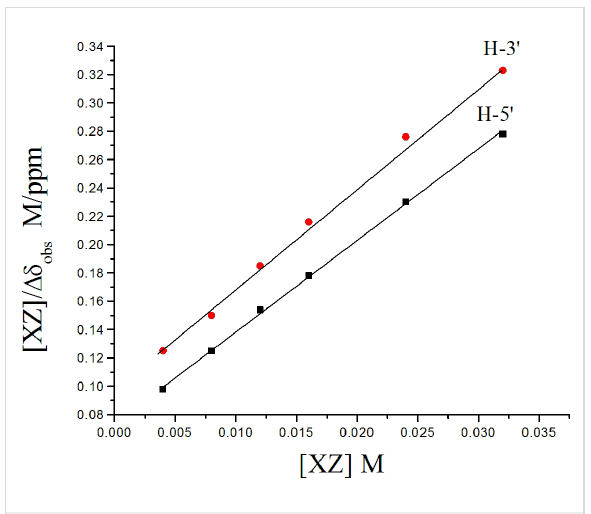
Figure 3: Scott’s plot of the chemical shift changes of β -CD cavity protons during titration with xylazine in D 2